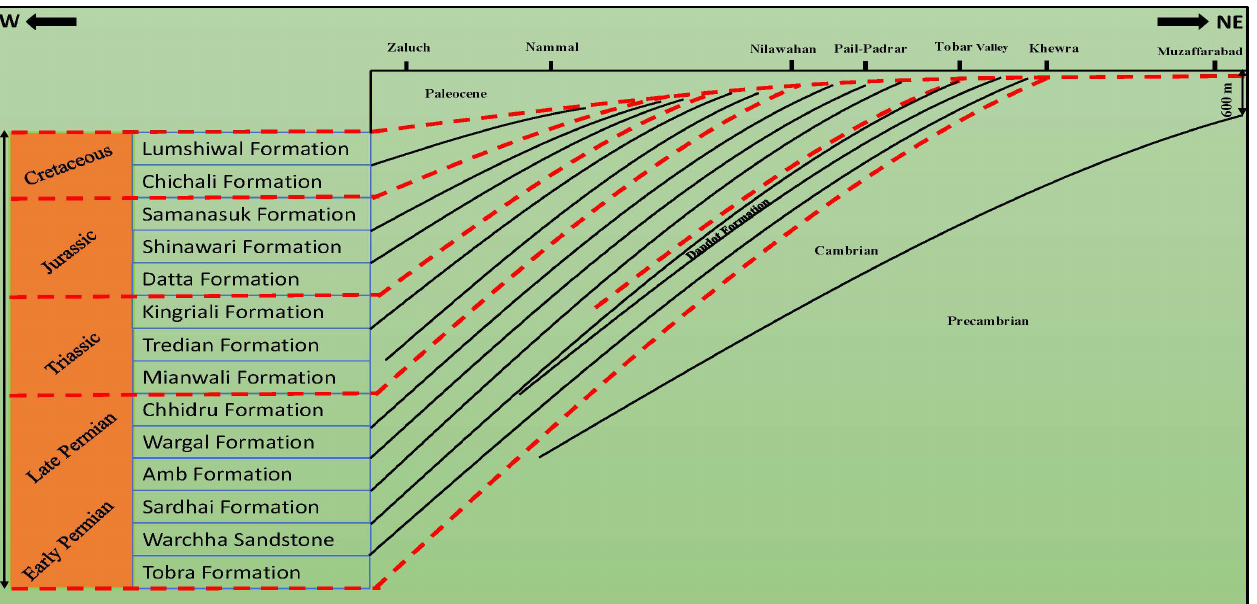
Figure 3. Simplified geological map of the study area.